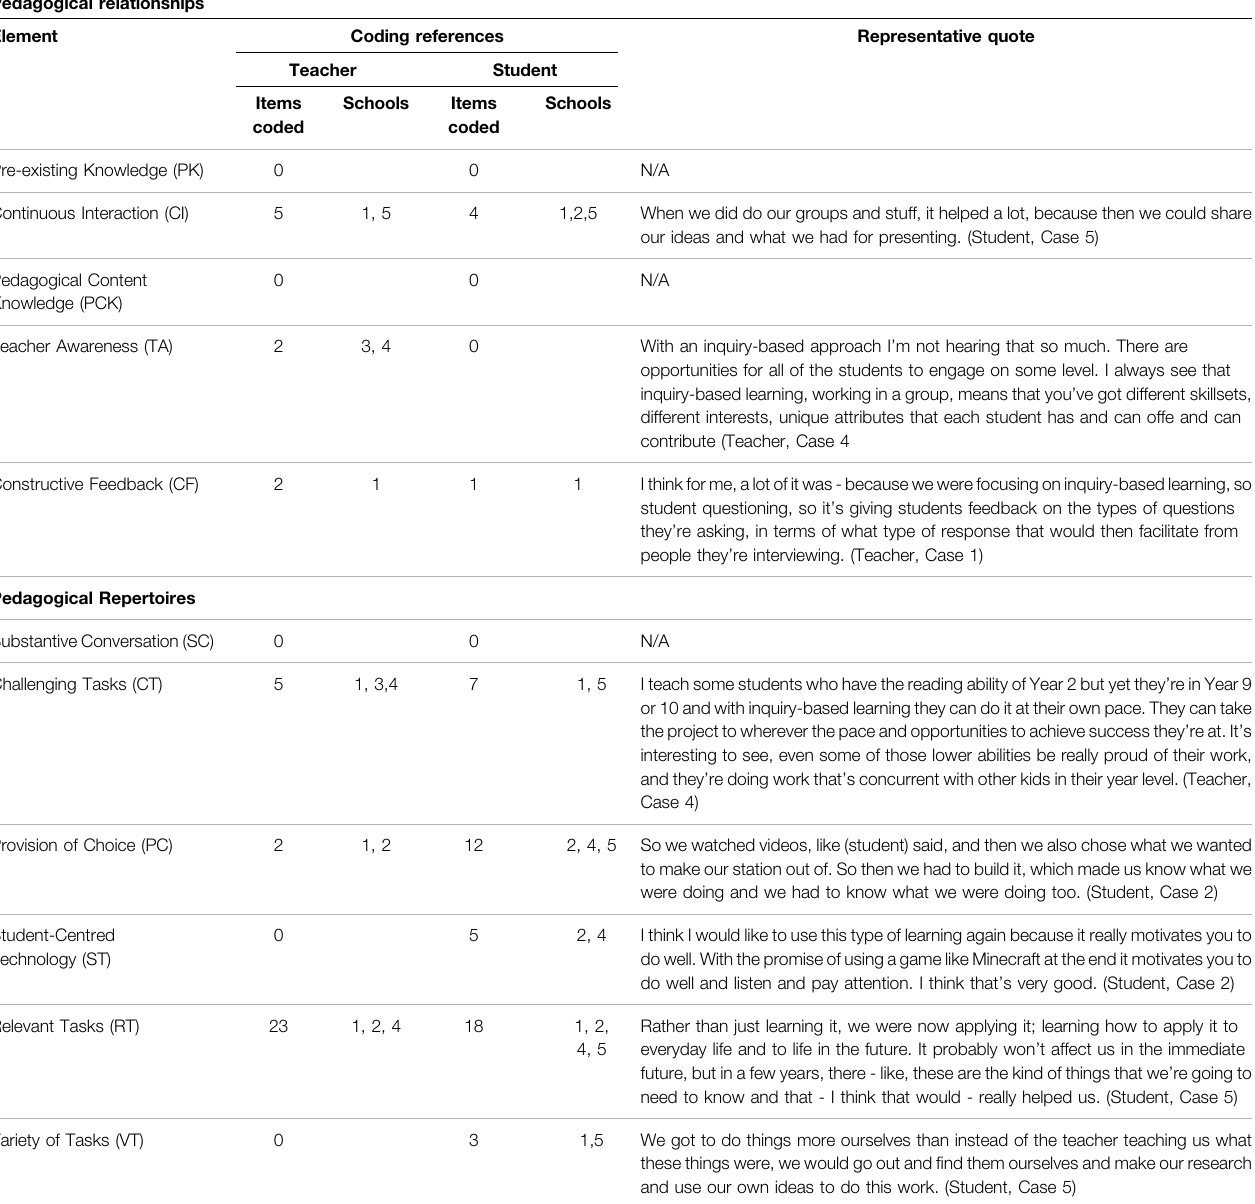
TABLE 3 | Coding table for Framework for Engagement with